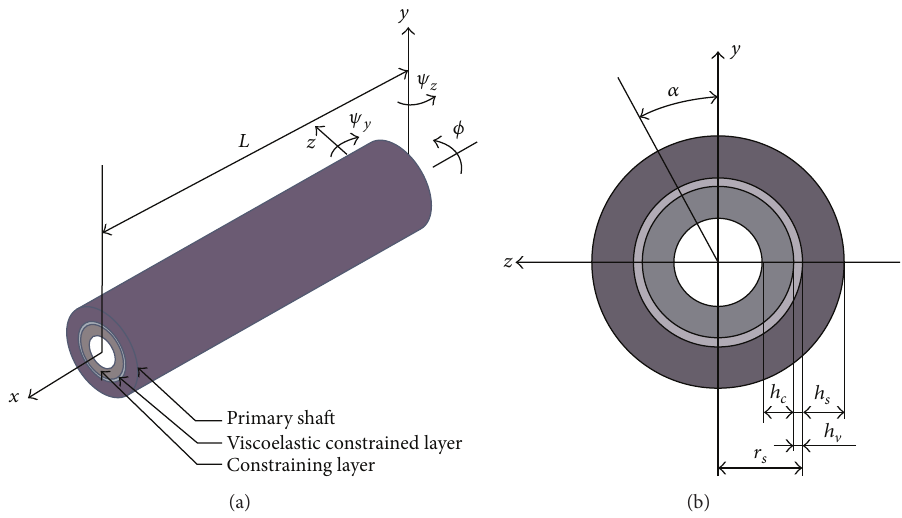
Figure 1: Geometric configuration of the composite shaft with a constrained damping